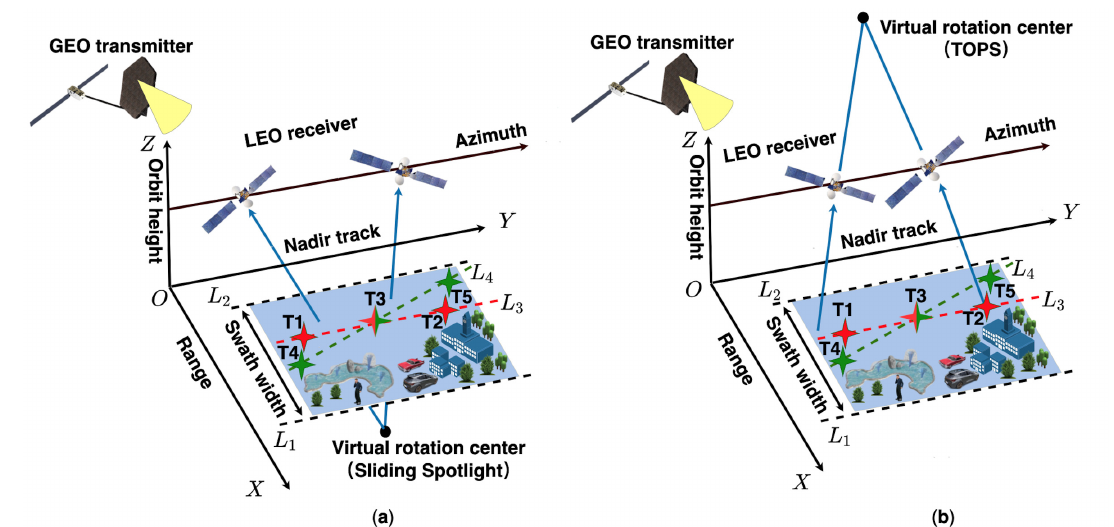
Figure 1. Imaging geometry of the GTLR-BiSAR system (not scaled). ( a ) Geometry of the GTLR- BiSAR system working in SS mode. ( b ) Geometry of the GTLR-BiSAR system working in TOPS